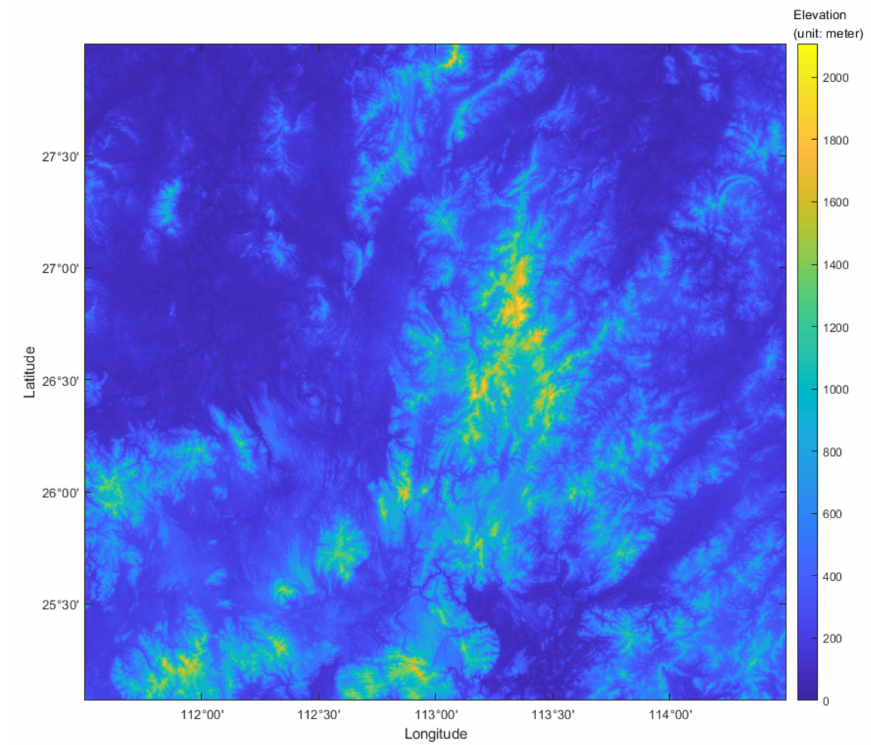
Figure 1. DEM dataset of the study